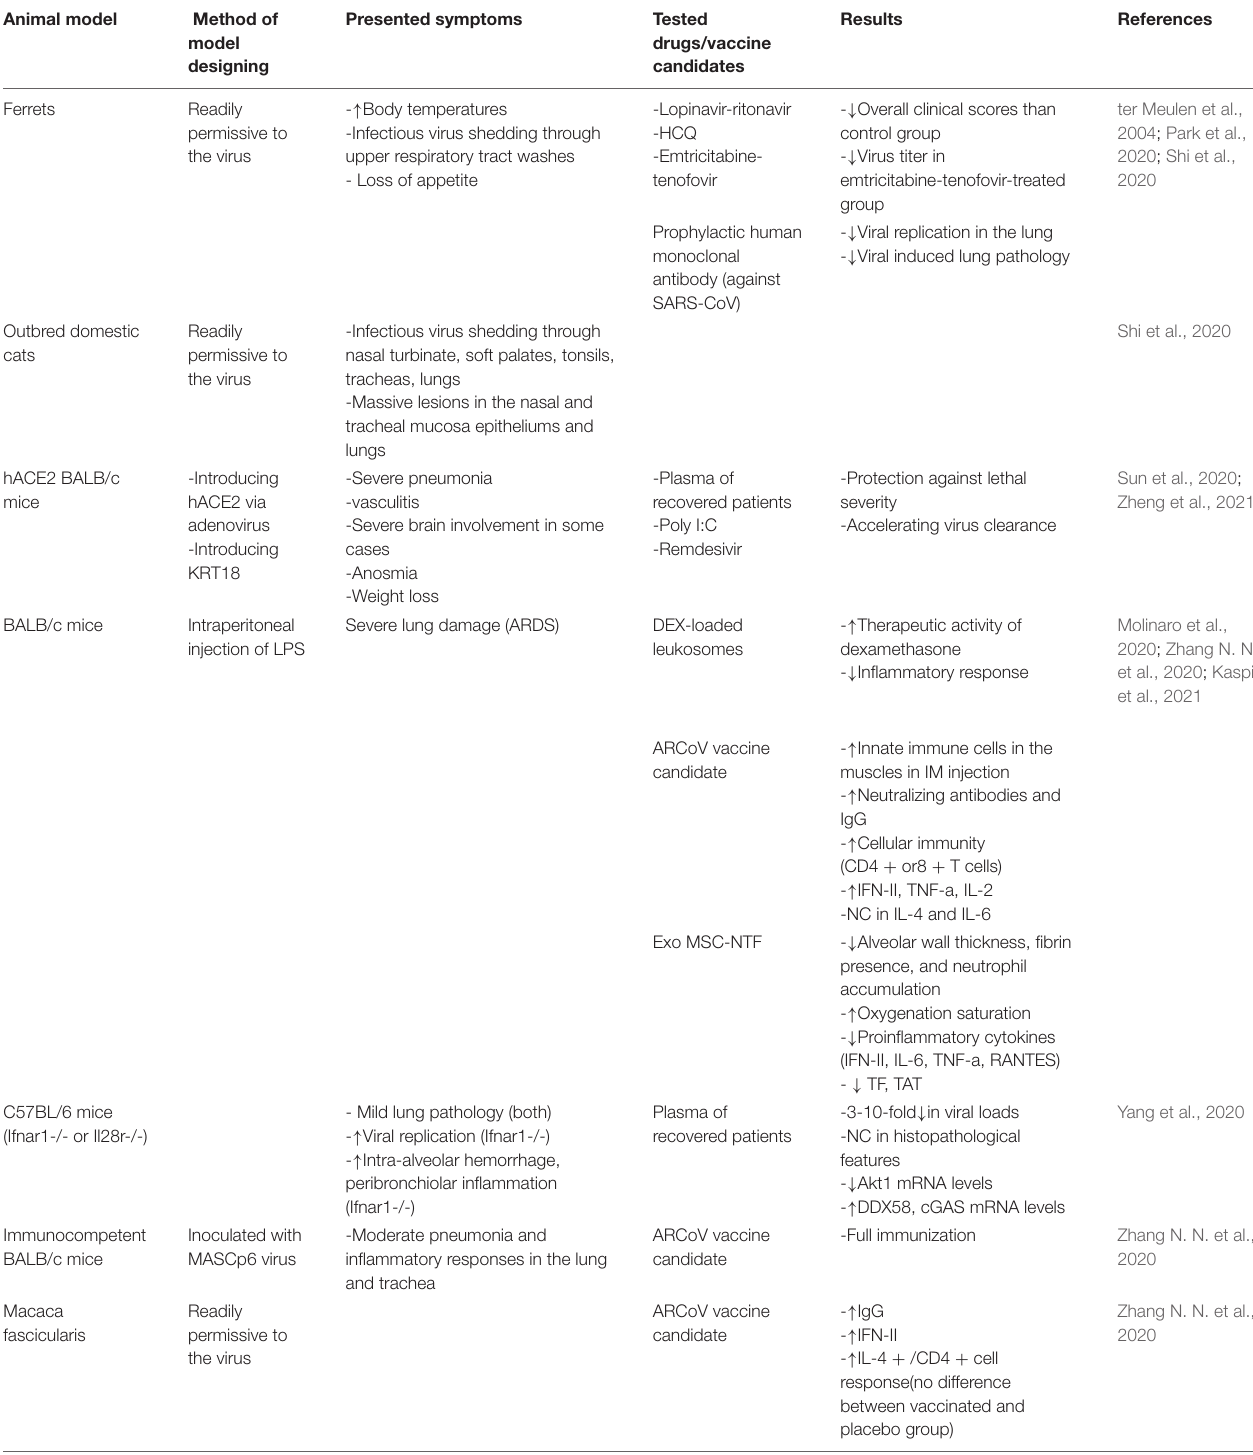
TABLE 2 | Animal models of Severe Acute Respiratory Syndrome Coronavirus-2 (SARS-COV-2) and the results of tested drug/vaccine